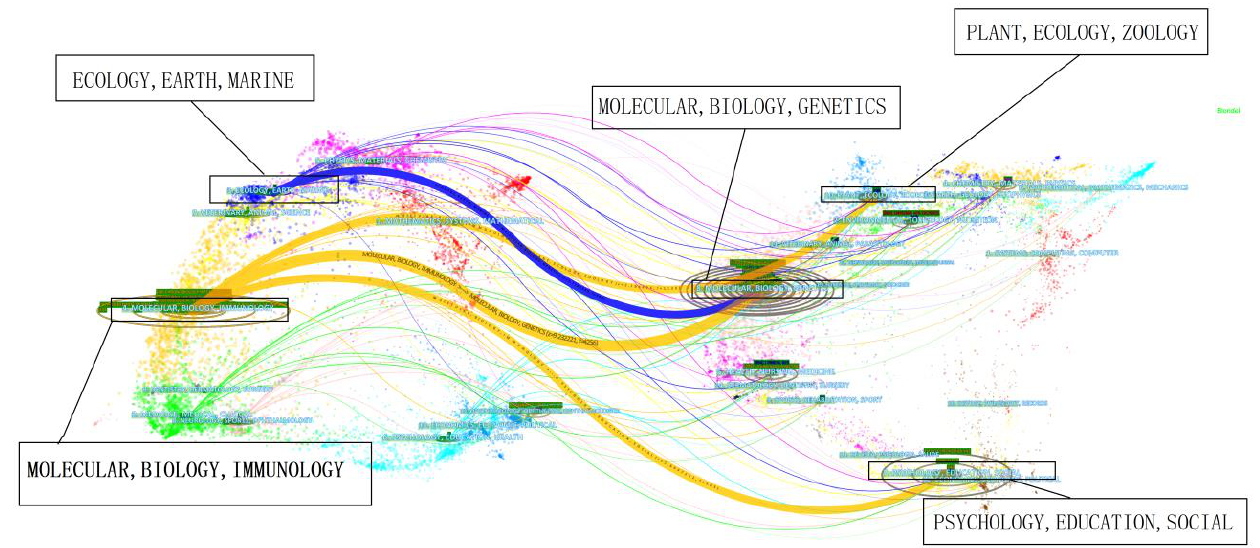
Figure 2. Dual-map overlays of research domains (The curve in the middle is the citation path, and the labels near the circle are the main research domains).